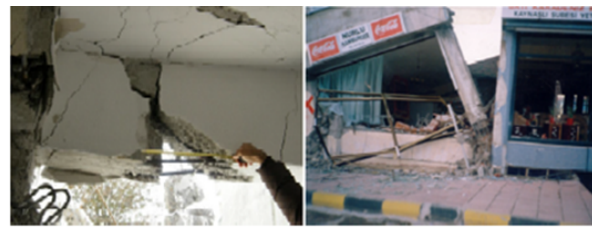
Figure 11. Pulling away of longitudinal reinforcements.